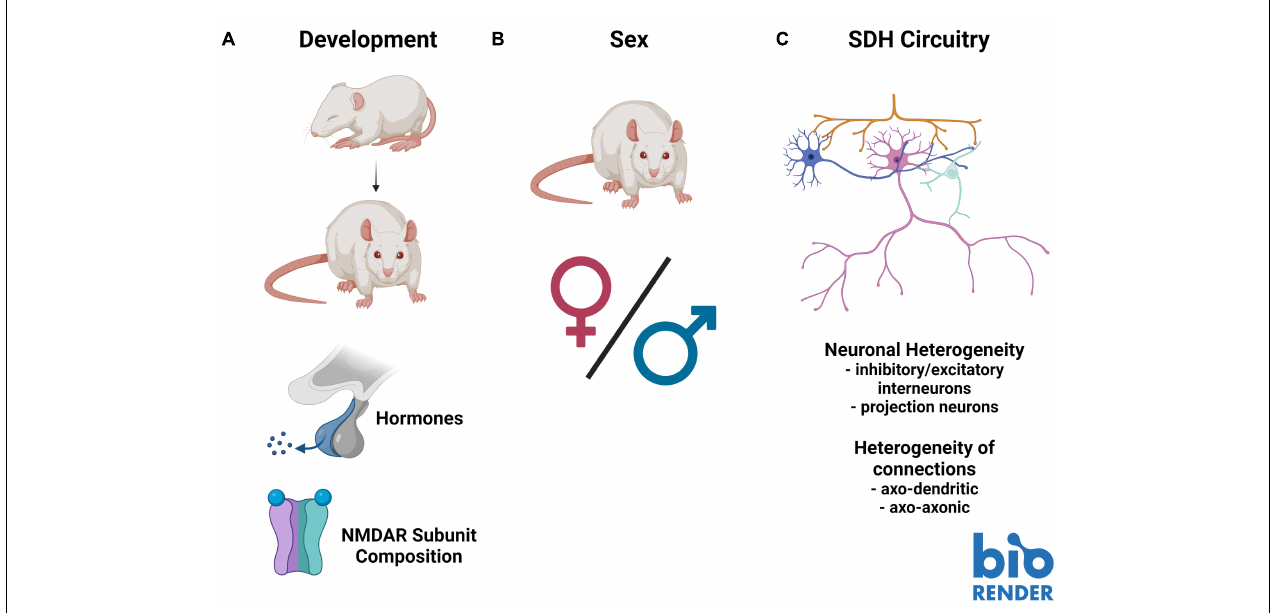
FIGURE 2 | Barriers to understanding the role of presynaptic N -methyl- D -aspartate receptors (preNMDARs) in superficial dorsal horn (SDH) nociception. (A) . Existing literature on preNMDARs in the SDH spans several developmental timepoints. This makes comparison between studies problematic, as NMDAR expression and composition may change throughout development. (B) . Almost all studies on preNMDARs in the SDH have been conducted in male or unsexed animals. Because data in recent years has demonstrated substantial sex differences in not only pain and nociception, but in the role of NMDARs in pain, it is critical for future studies to examine preNMDARs in females. (C) . The complex circuitry and unknown connectivity of the SDH makes interpreting overall output from the contributions of preNMDARs difficult. Increased mapping of the connectivity of distinct neuronal subpopulations, such as primary afferent terminals, inhibitory and excitatory interneurons, as well as projection neurons, in addition to understanding the distinct contributions of axo-dendritic and axo-axonic connections, will be vital to fully understand the role of preNMDARs in nociception in the SDH. Figure was created using BioRender.com.